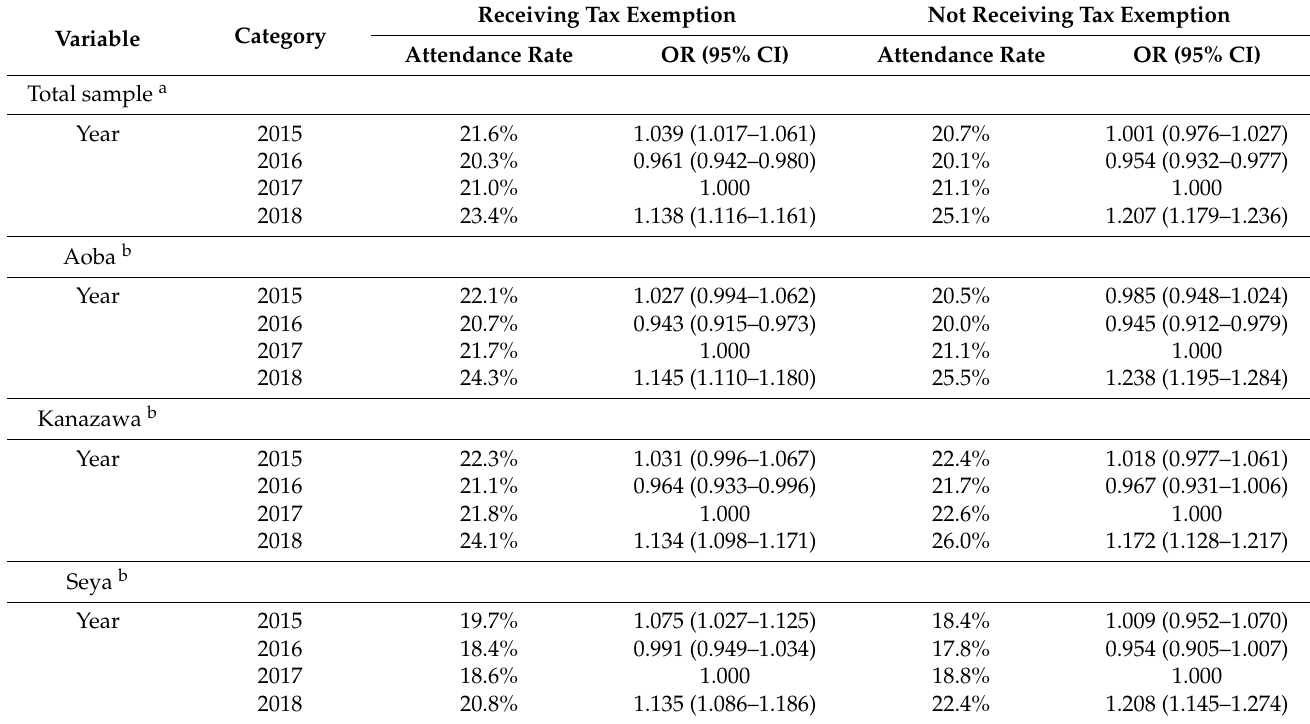
Table 6. Stratified analysis by tax exemption status for increases in specific health check attendance after the out-of-pocket cost removal intervention: total sample and subgroups by residential